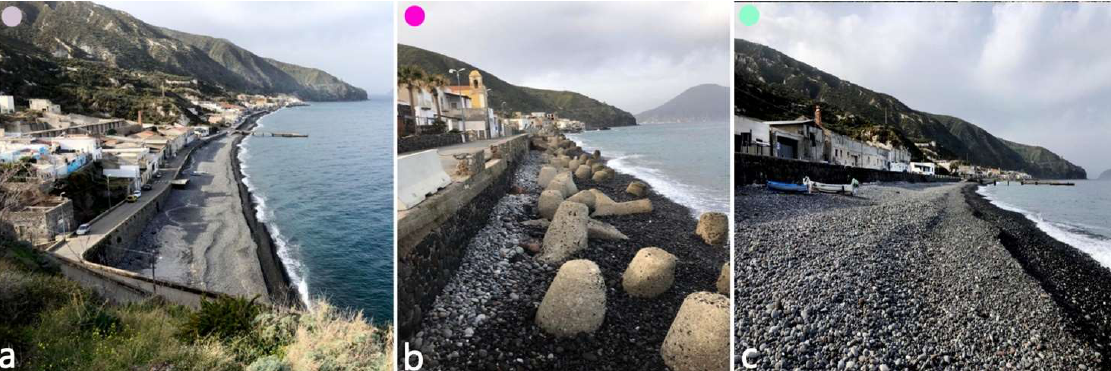
Figure 4. Panoramic view of the Acquacalda bay ( a ) and zoom of the central ( b ) and the western side ( c ). Location of pictures is in Figure 1 through respective colored dots.